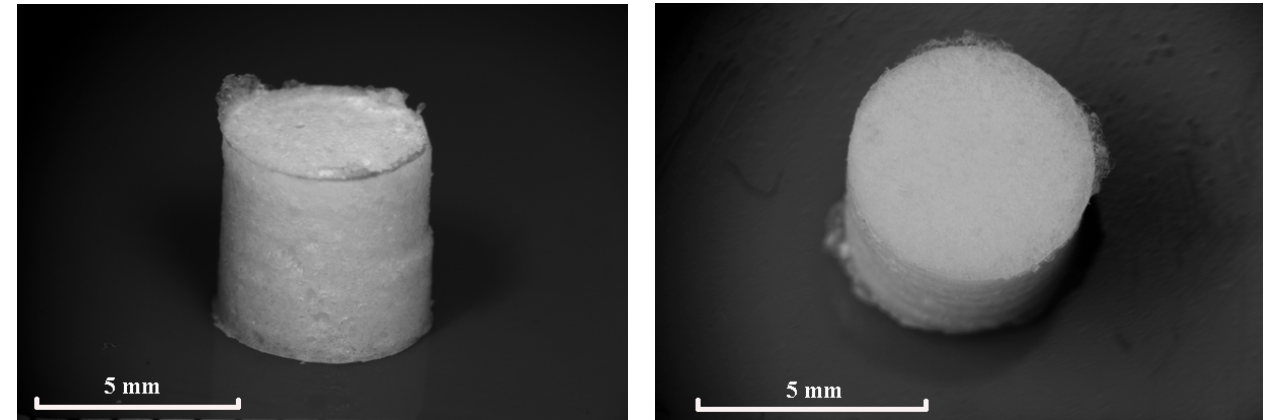
Figure 1. Optical images of PDLG 7502 porous samples.